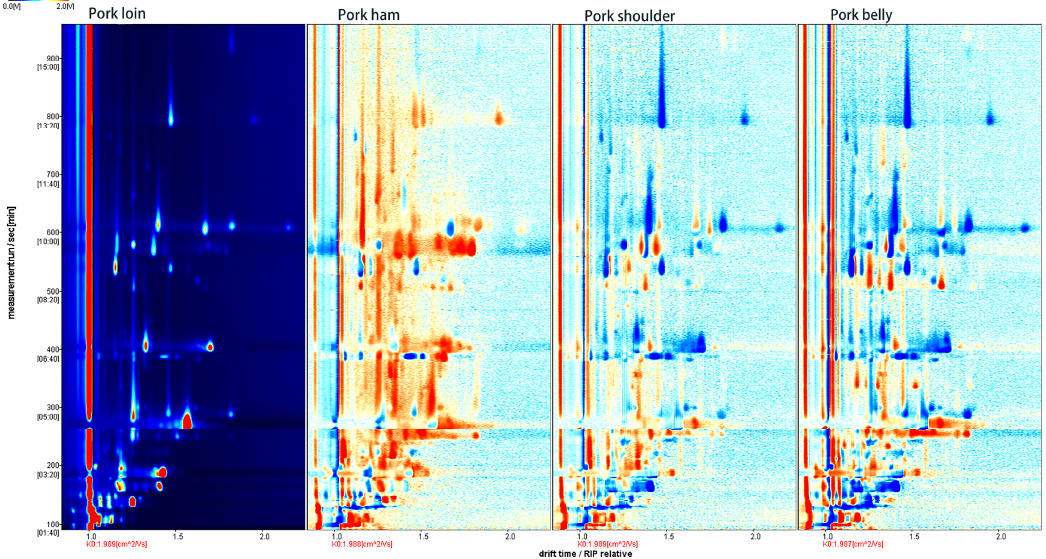
Figure 2. Comparison of differences in 2D GC-IMS spectra of volatile organic compounds in four muscles of pork.